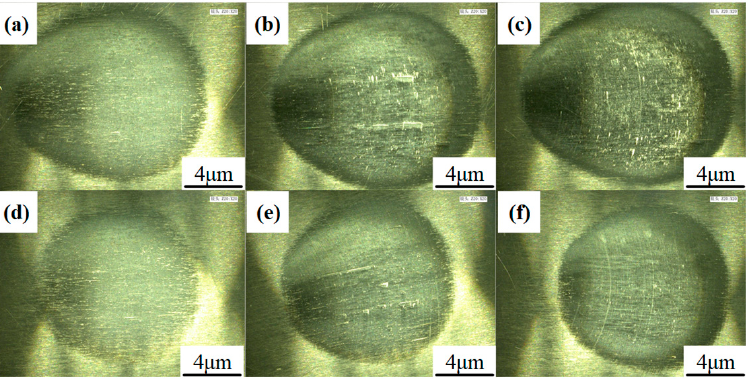
Figure 7. The super depth of field morphology of TIFs subjected to different bonnet tools: ( a – c ) The TIFs of the SR bonnet under different dwell times of 30 s, 180 s, and 300 s; ( d – f ) the TIFs of PR bonnet under different dwell times of 30 s, 180 s, and 300 s.